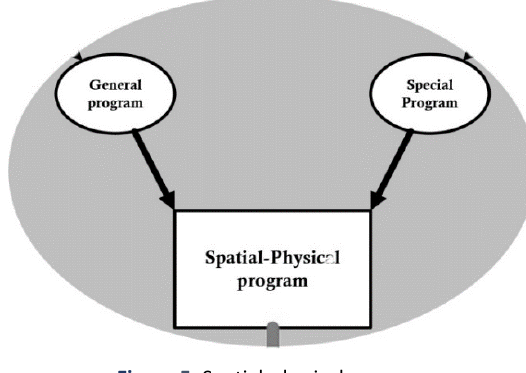
Figure 5. Spatial-physical program